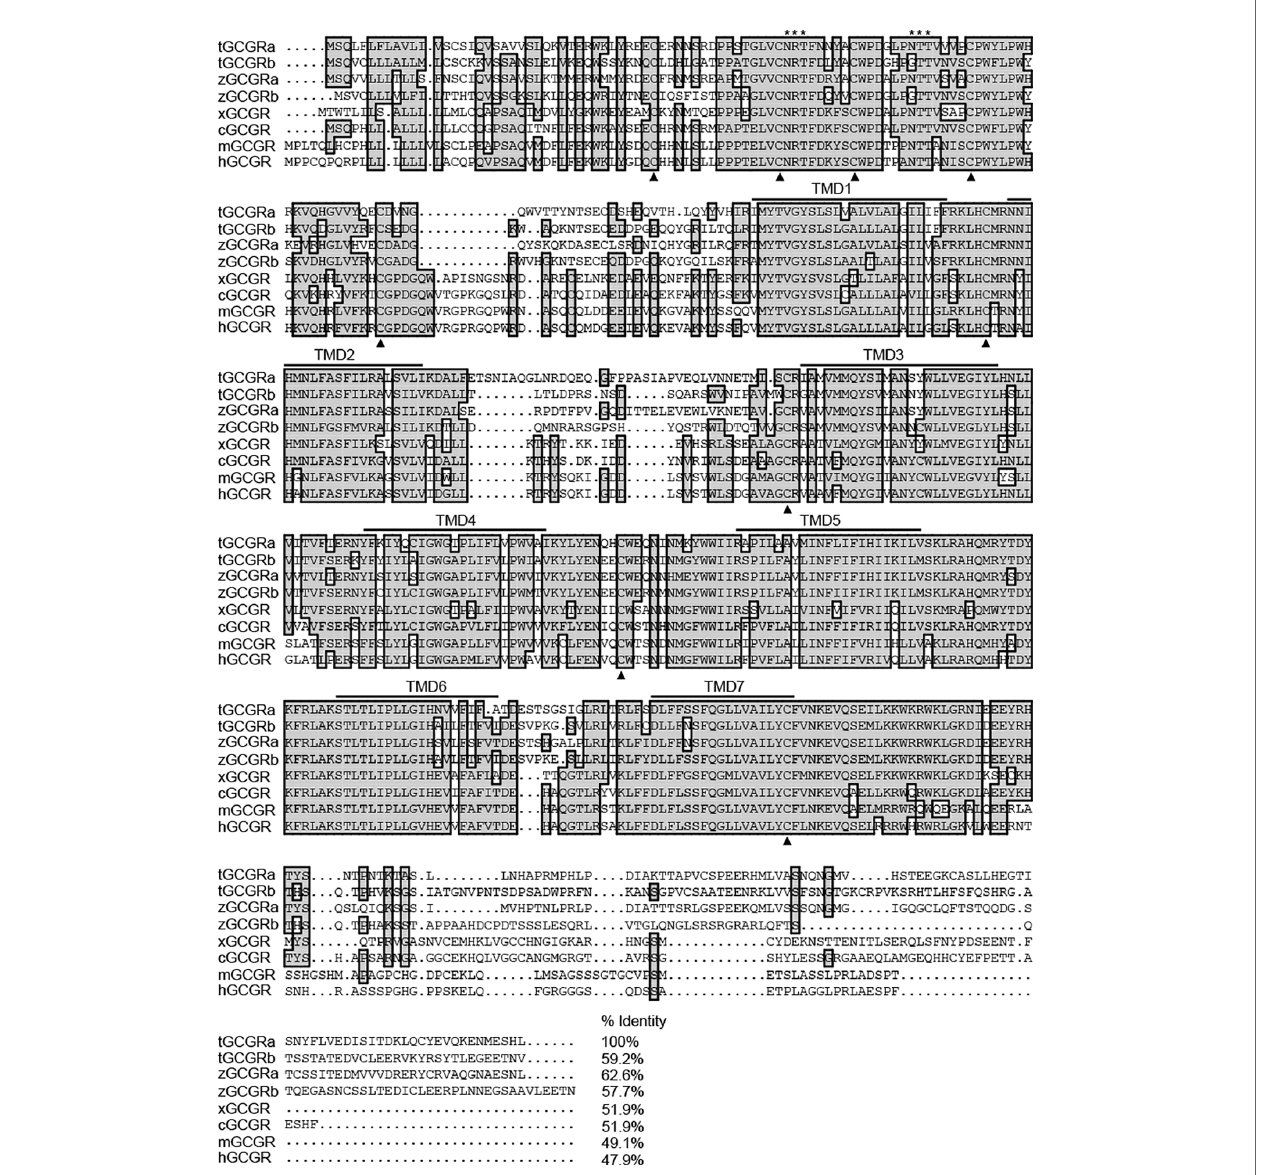
FIGURE 2 | Alignment of tilapia GCGRs amino acid with the corresponding GCGR sequences reported in other species. Conserved amino acids are shaded. Dots (represented by (cid:129) ) are introduced to maximize sequence homology. Putative TMDs are overlined and labeled 1 – 7. An asterisk (*) represents potential N-linked glycosylation sites, and conserved cysteine residues are indicated as bold triangles. The sequences of GCGRs for other species were downloaded from the GenBank and/or by searching Ensembl genomes. GenBank accession numbers or Ensembl IDs are as follows: tilapia GCGRa (tGCGRa, MT488305), tilapia GCGRb (tGCGRb, MT488306), zebra fi sh GCGRa (zGCGRa, ENSDARP00000139469), zebra fi sh GCGRb (zGCGRb, ENSDARP00000013211), Xenopus GCGR (xGCGR, NP001079221), chicken GCGR (cGCGR, NP001094505), mouse GCGR (mGCGR, AAH57988), and human GCGR (hGCGR,